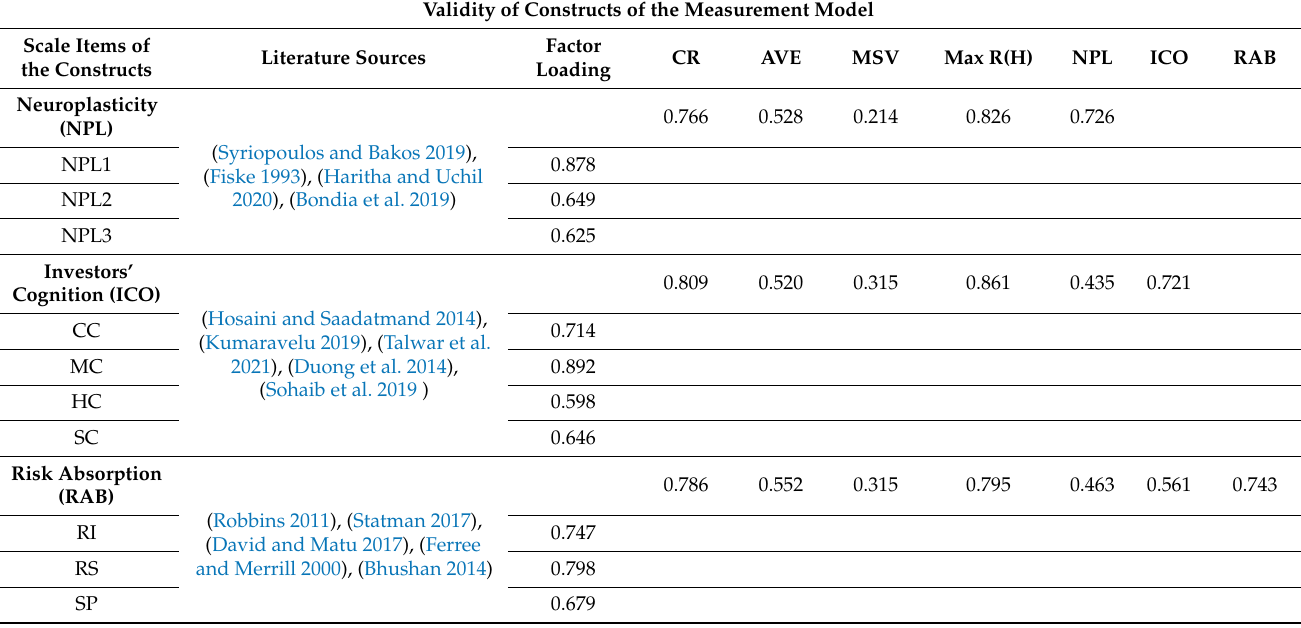
Table 2. Comparison of acceptable (standard) parameter values and the observed values of the latent variables of the